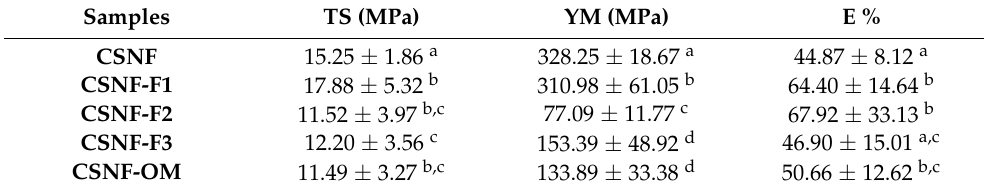
Table 4. Mechanical properties of the films (TS: tensile strength; YM: Young’s modulus; E: elongation). Samples